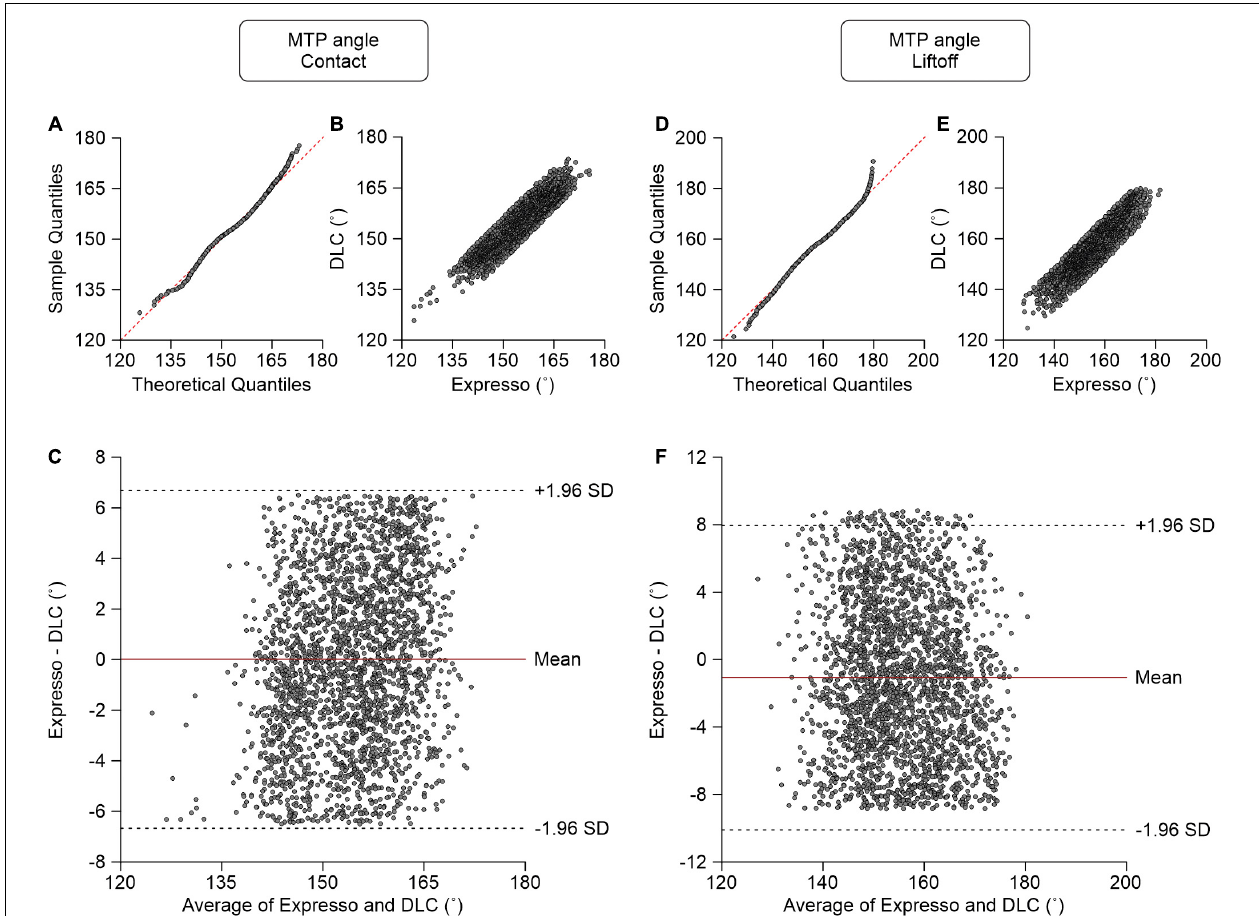
FIGURE 8 | Comparison of metatarsophalangeal joint angles at contact and at liftoff measured with data from Expresso and DLC. (A) MTP angle at contact QQ-plot where the red dashed line represents a perfect normal distribution. (B) MTP angle at contact scatter plot of values obtained with Expresso and DLC. (C) Bland–Altman plot of MTP angle at contact measurements from Expresso and DLC. The solid red line is the mean difference between the two methods and black dashed lines show ± 1.96 standard deviations. (D) MTP angle at liftoff QQ-plot where the red dashed line represents a perfect normal distribution. (E) MTP angle at liftoff scatter plot of values obtained with Expresso and DLC. (F) Bland–Altman plot of MTP angle at liftoff measurements from Expresso and DLC. The solid red line is the mean difference between two methods and black dashed lines show ± 1.96 standard